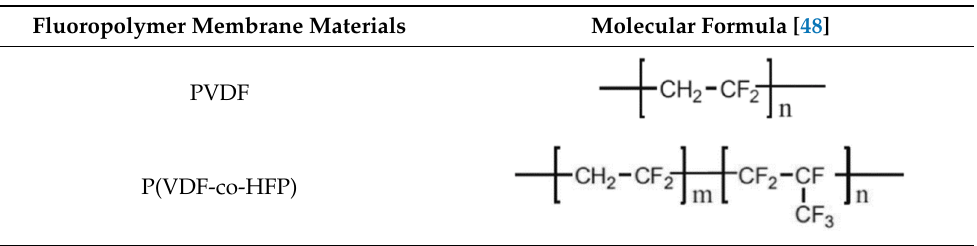
Table 2. Molecular formula of the most used hydrophobic fluoropolymer materials for MD and MCr.